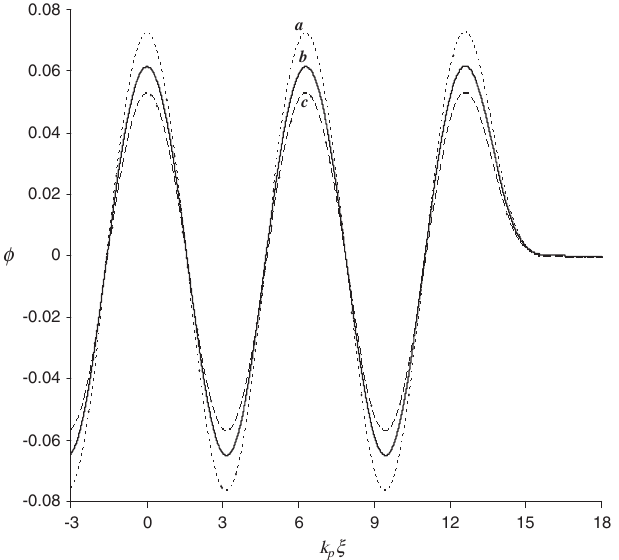
FIG. 2. Variation of normalized longitudinal electrostatic po- (cid:5) for (cid:1) ¼ (cid:4) 1 (curve a ), (cid:1) ¼ 0 (curve b ), and tential ð (cid:7) Þ with k p ¼ 32 (cid:9) m , and L ¼ 7 : 2 (cid:9) m . (cid:1) ¼ þ 1 (curve c ) for a 0 ¼ 0 : 3 , (cid:8) p